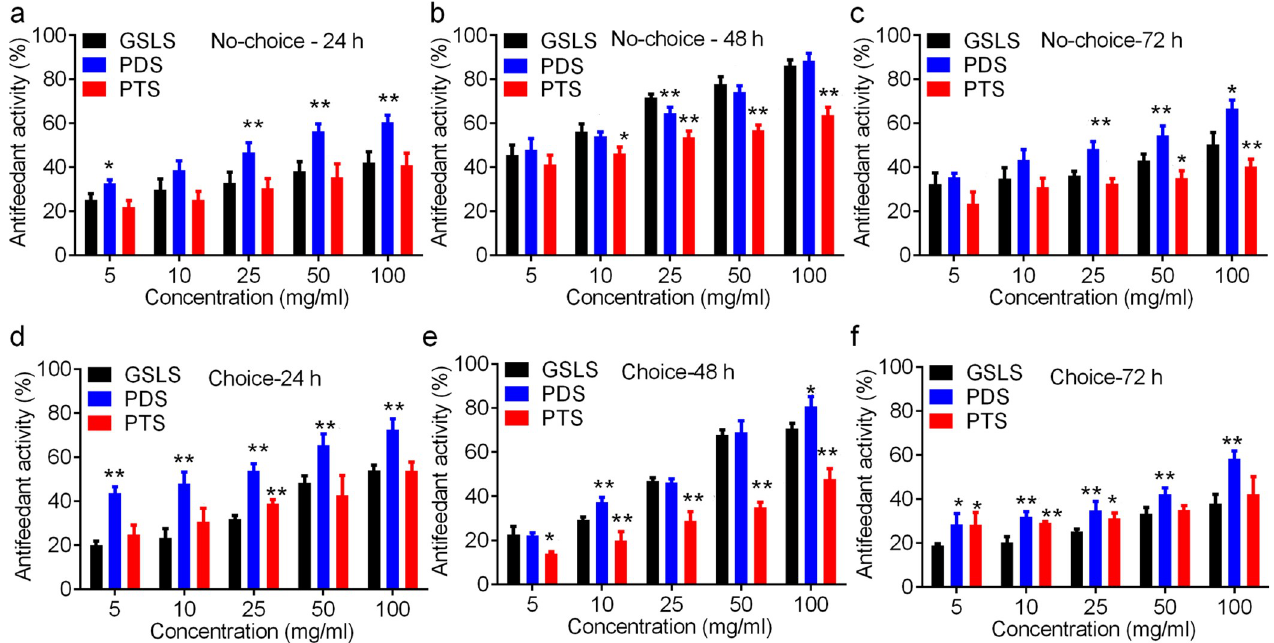
Fig 4. Antifeedant activity of ginsenosides against the 3 rd instar larvae of O . furnacalis . a-c, no-choice antifeedant activity of ginsenosides against O . furnacalis larvae for 24 h, 48, and 72 h, respectively. d-f, choice antifeedant activity of ginsenosides against O . furnacalis larvae for 24 h, 48, and 72 h, respectively. � and �� notes p < 0.05 and 0.01 vs. GSLS (total ginsenosides from of ginseng stems and leaves) in each concentration, respectively. PDS, panaxadiols saponins; PTS, panaxatriol saponins. Original data of no-choice and choice antifeedant activity analysis are available from S2 and S3 Tables, respectively.